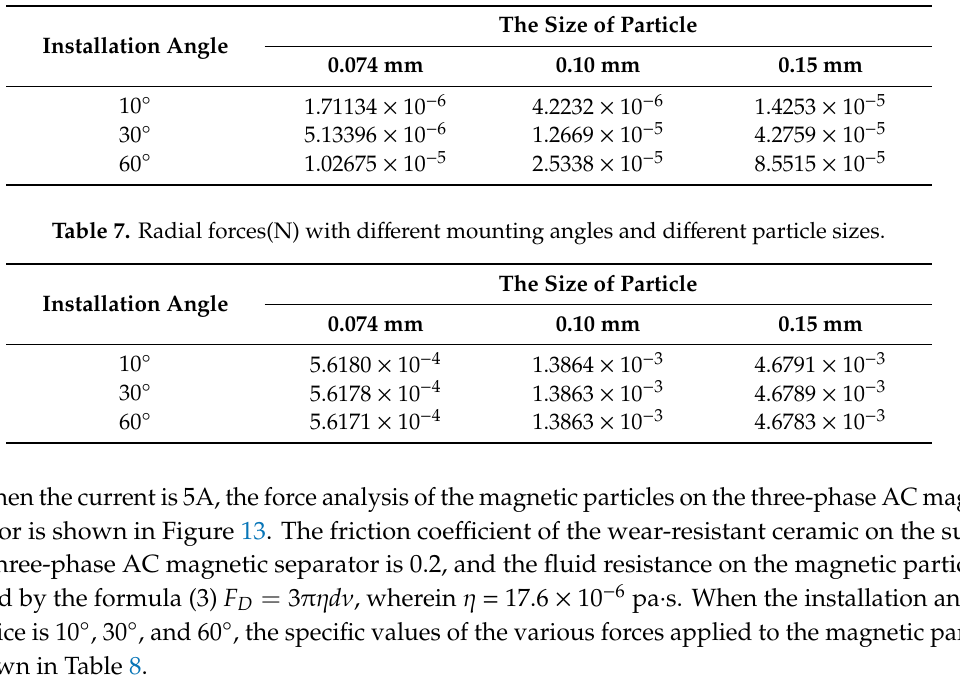
Table 6. Tangential forces(N) at di ff erent installation angles and di ff erent particle sizes.